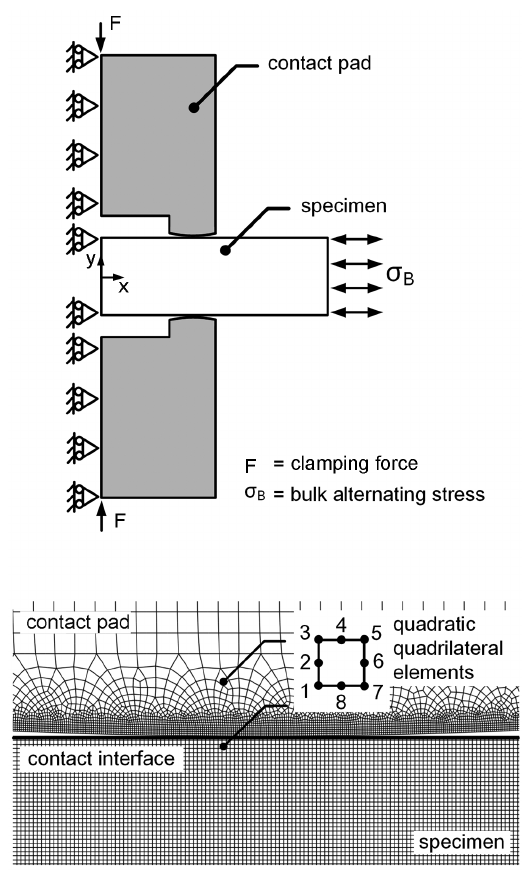
Figure 5. FEA model for the determination of location of crack nucleation.